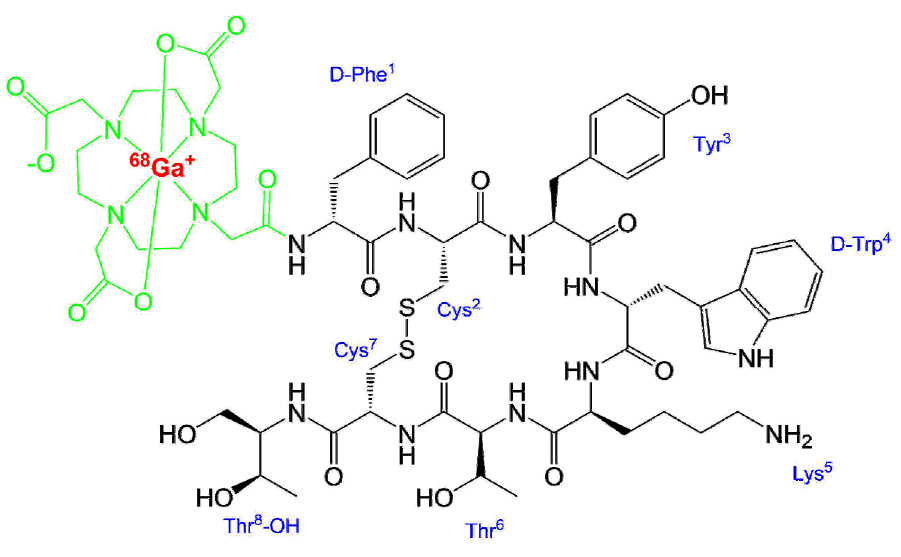
Figure 3. Structure of [ 68 Ga]Ga-DOTA-TOC.